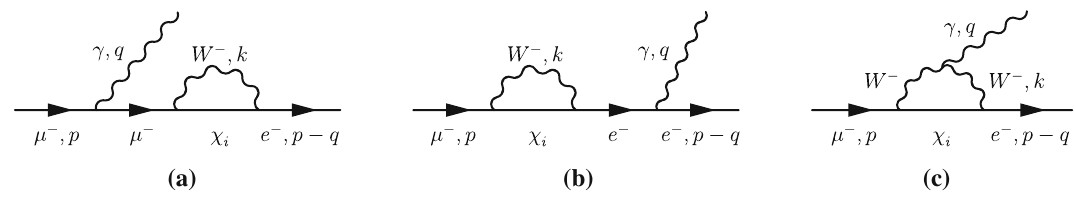
Fig. 2 The one-loop Feynman diagrams contributing to μ − → e − + γ in the unitary gauge, where χ χ = ν with mass m for i = 1 , 2 , 3) or n sterile neutrinos (i.e., χ i i i mixing scheme